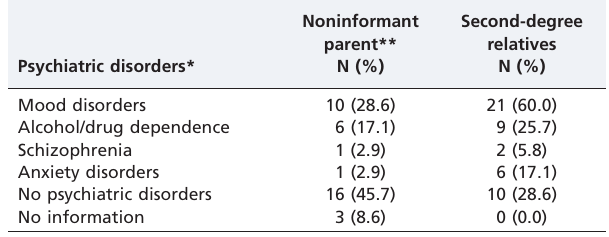
Table 2 - Family psychiatric histories of the offspring of bipolar parents (N =